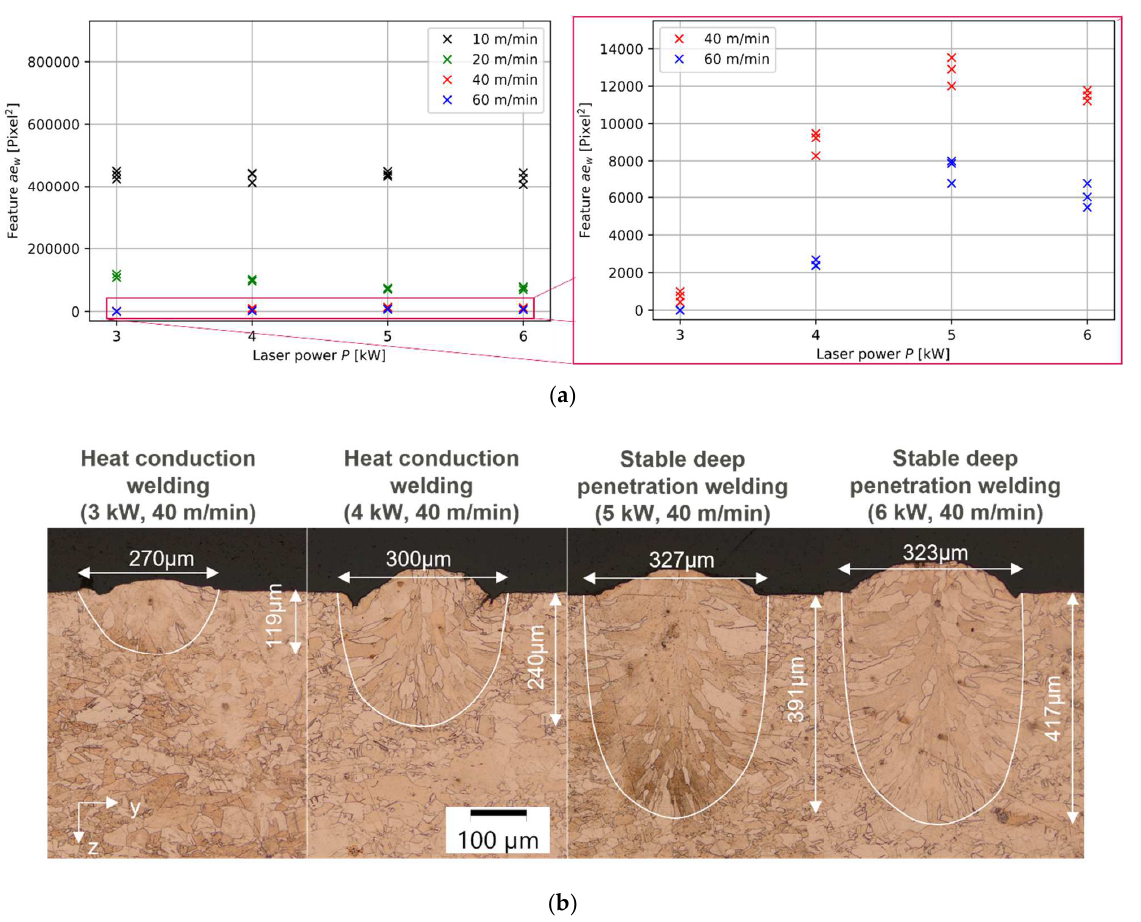
Figure 5. ( a ) Feature value over laser power for different laser welding speeds; ( b ) Metallographic cross-sections for different laser powers at a constant laser welding speed of 40 m/min.